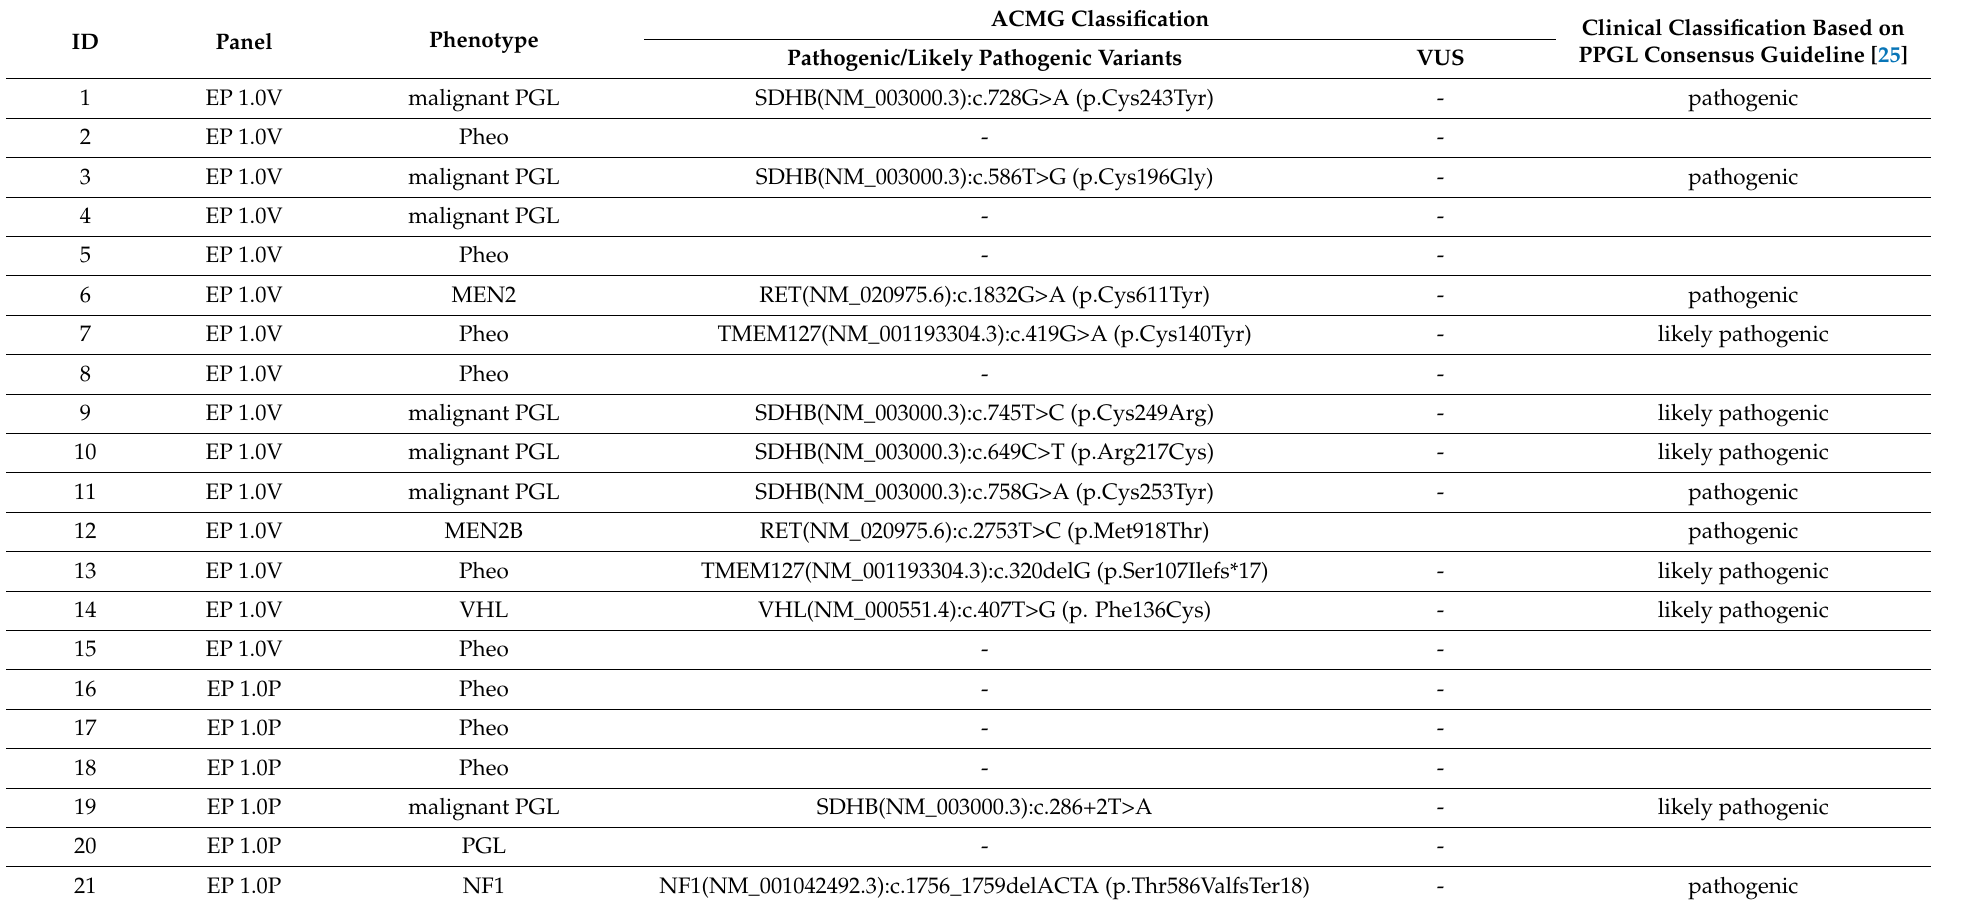
Table 3. Variants identified with ENDOGEN panels v1.0, and v2.0 and the associated